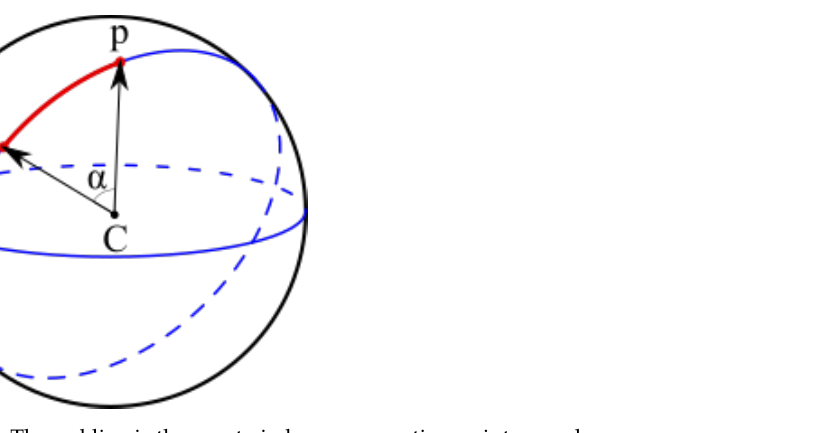
Figure 7. The red line is the great-circle arc connecting points p and q